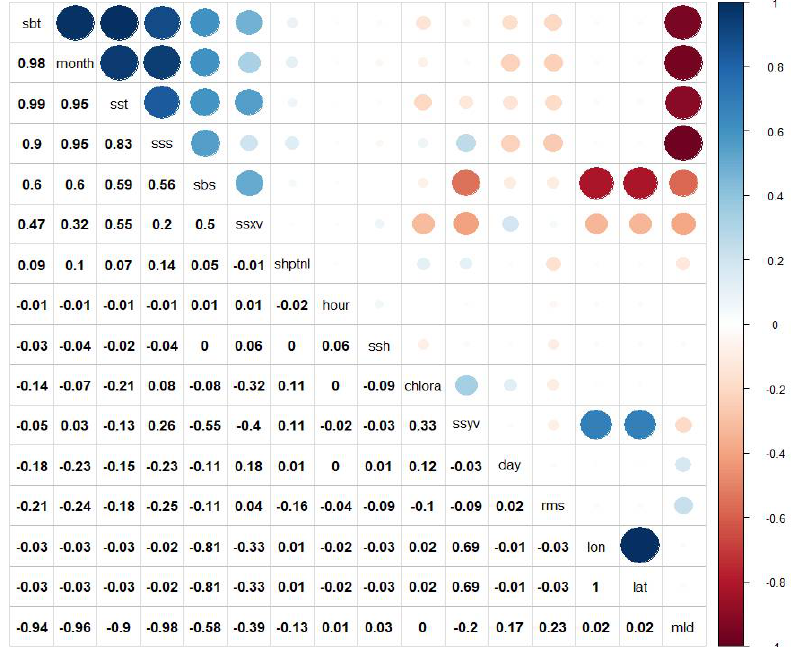
Figure 3. This correlogram was plotted using the corrplot() function (“corrplot” package). The size of the circle is directly proportional to the correlation coefficients while blue represents the positive correlations and red the negative. This figure indicates the measure of collinearity between the different variables used in the modelling.